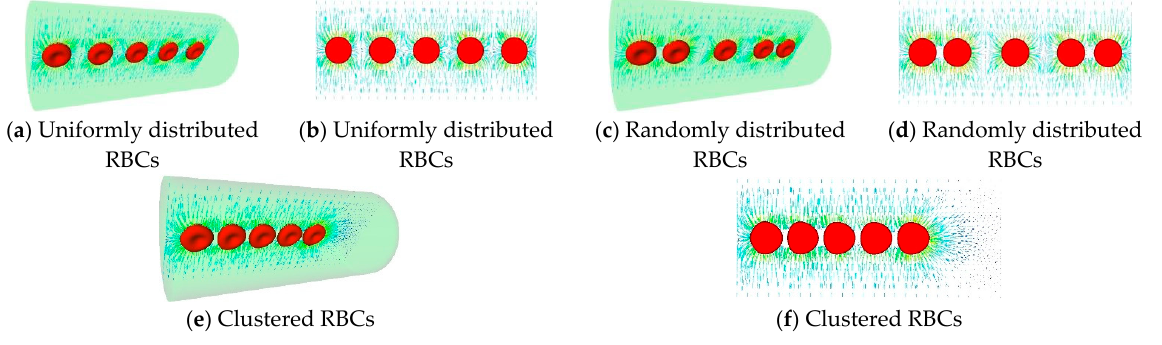
Figure 6. The CO flux for various RBCs distributions.